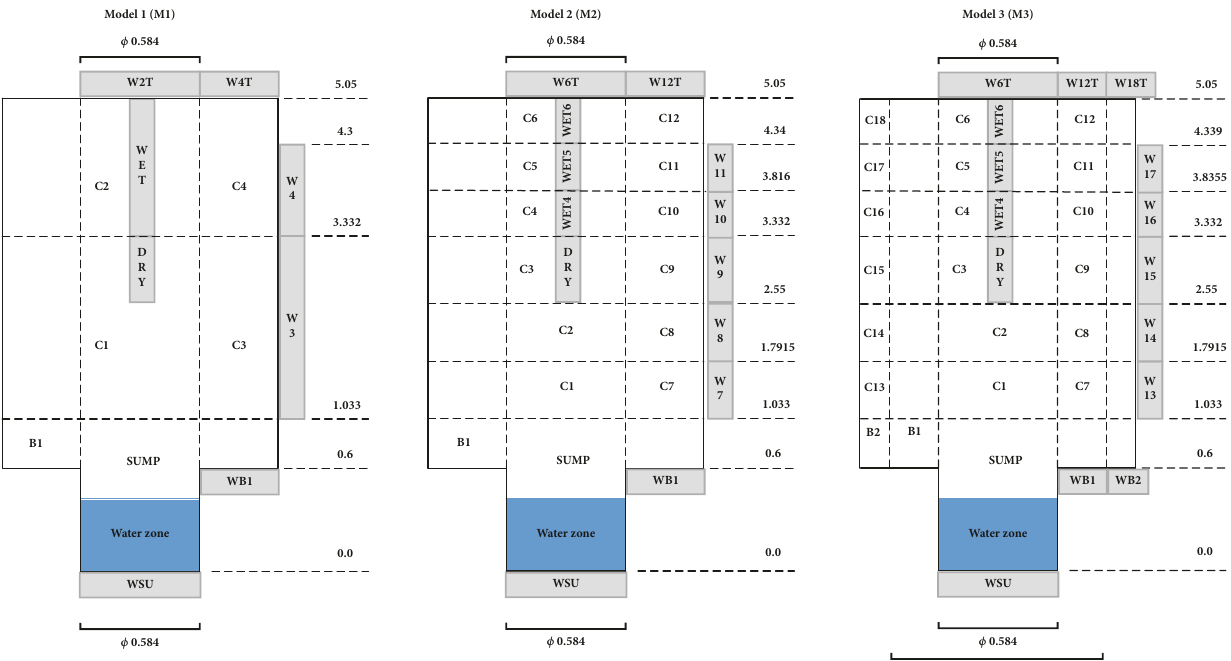
Figure 5: Sketches of the employed CV